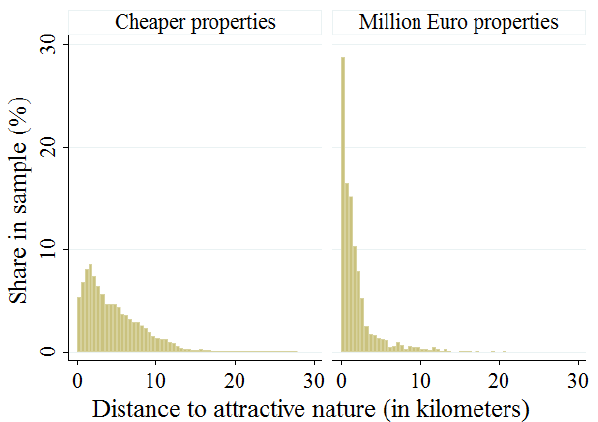
Figure 3. Sample distribution by distance to nearest attractive nature, per 0.5 km (km) interval. The 0.25, 0.50, and 0.75 quartiles are within the sample of million Euro properties, 0.39 km, 1.17 km, and 2.29 km, respectively, and in the same order, 1.79 km, 3.71 km, and 6.69 km in the case of the sample of lower priced properties (transaction prices below 1 million Euros).